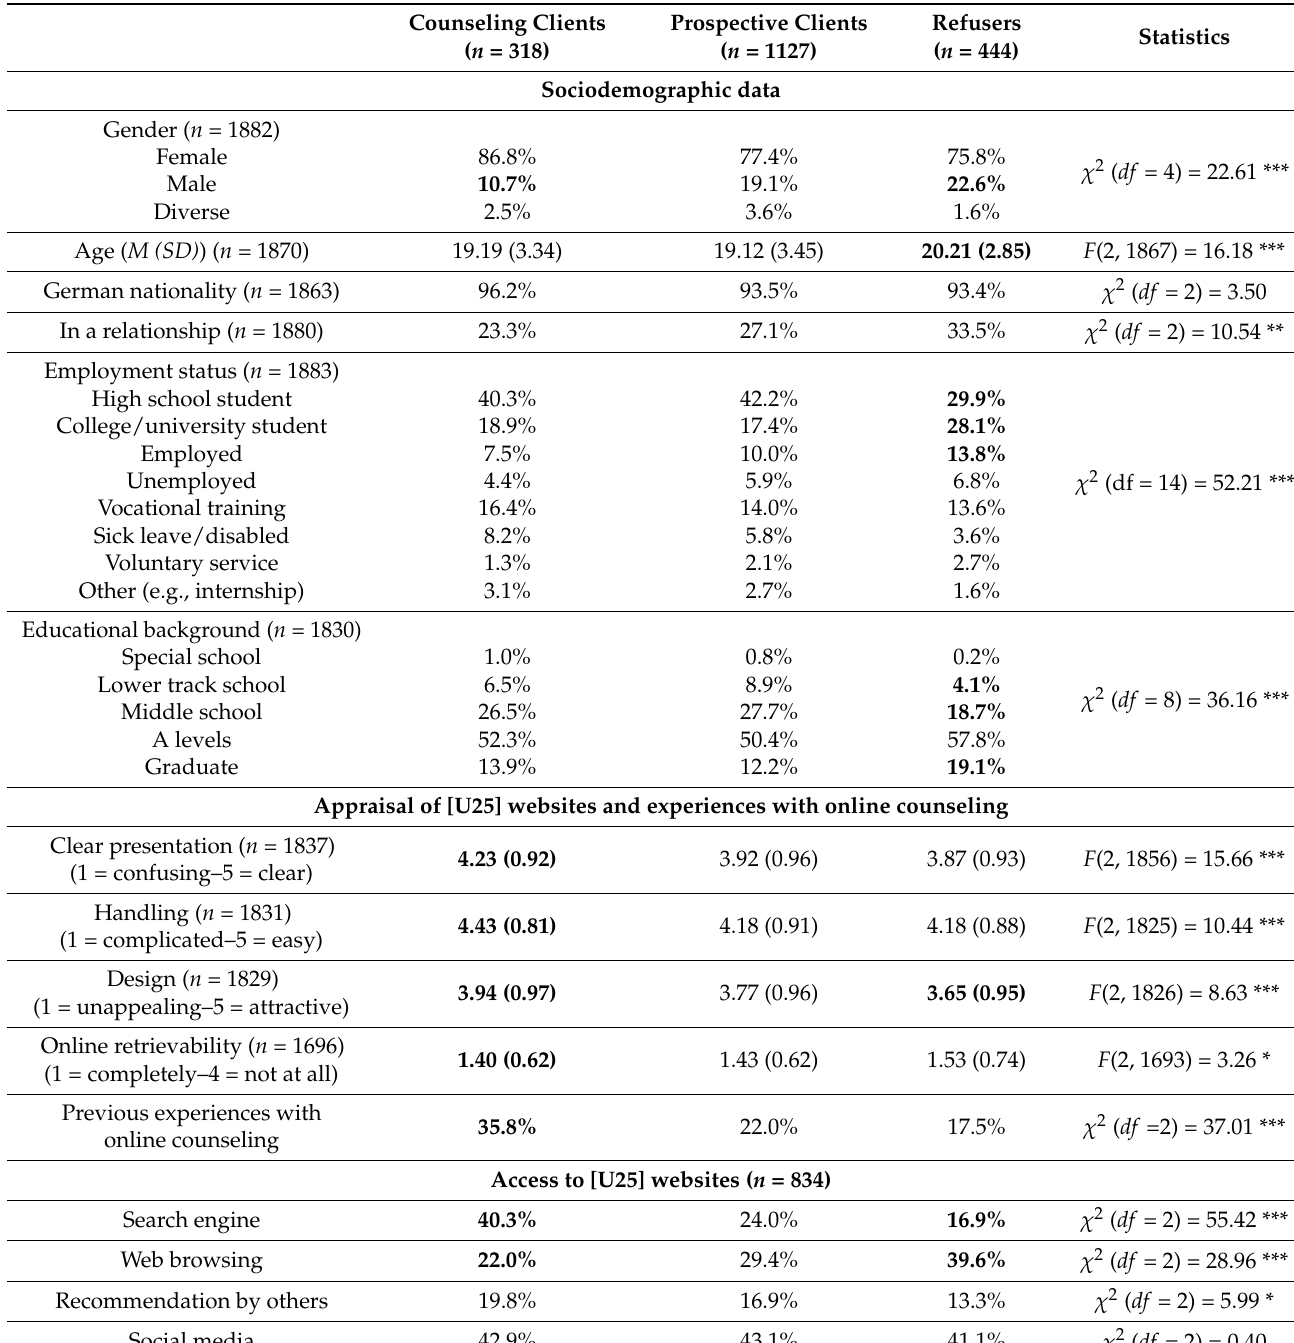
Table 1. Comparison of counseling clients, prospective clients, and